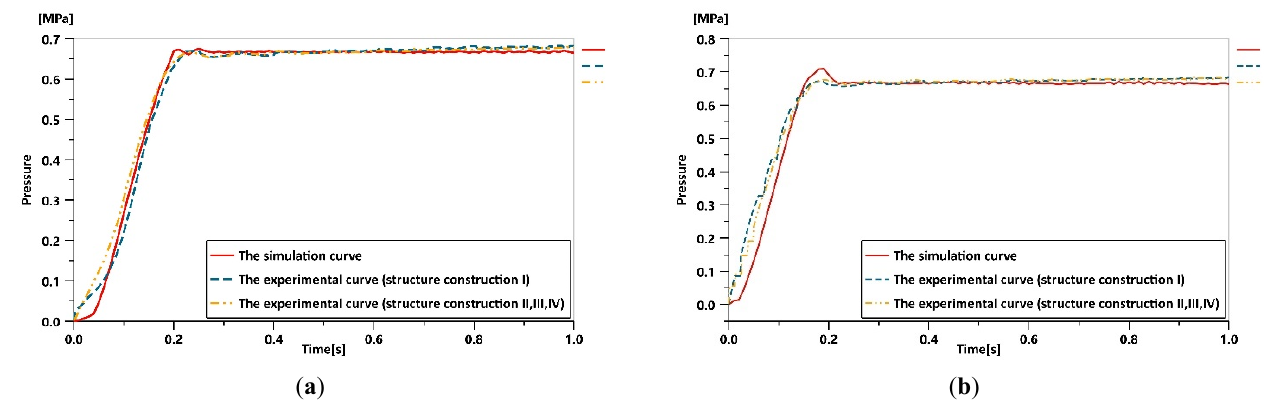
Figure 6. Verification of the simulation model for the pressure regulation characteristics of the APRV of the different structural configurations in the ECPBS of commercial vehicles: ( a ) manual control and ( b ) electronic control.